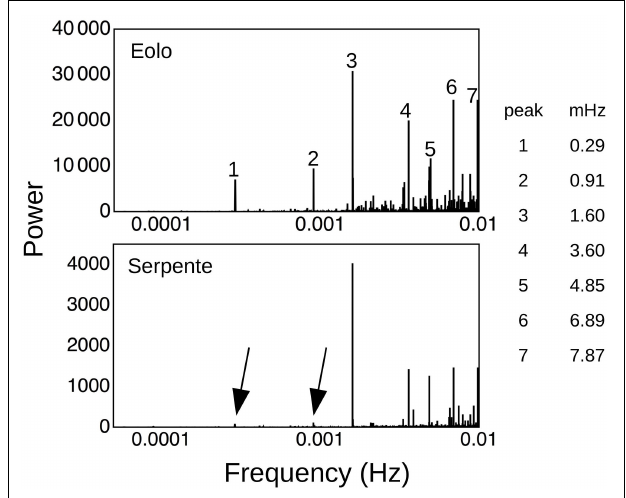
FIGURE 4 | Spectral analysis of the system’s response. The response of the cave system has been estimated by deconvolution of wind speed signals recorded at the Eolo and Serpente entrances (considered as the system outputs) and the external pressure signals (considered as the system input). The analyses reveal common peaks. In the Serpente case, the two peaks at frequencies < 1 mHz are only vaguely visible on this scale but are well above the baseline (arrows). Note that in both spectra the x -axis has been interrupted at 0.05 mHz. At lower frequencies the spectrum is